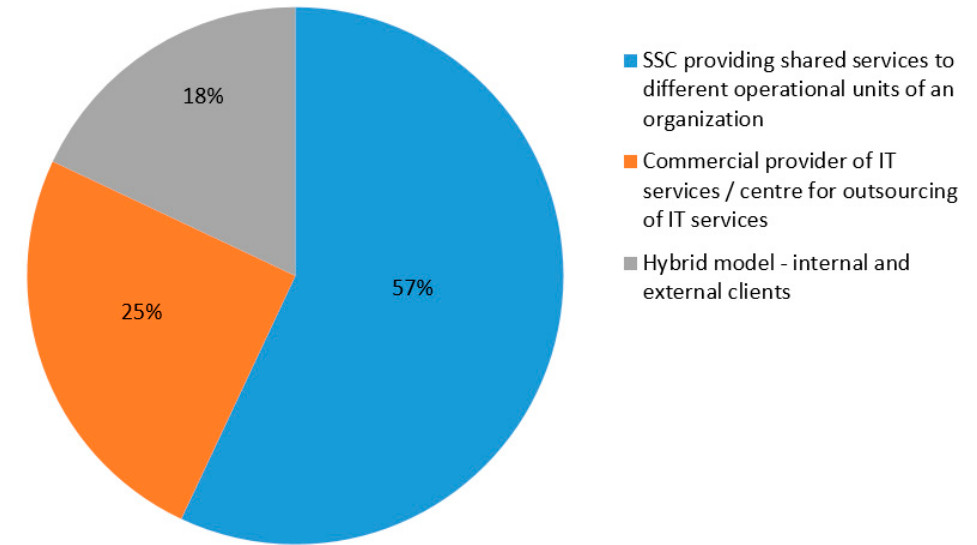
Figure 4. Types of shared services centres in 2005 in Poland. Source: Author’s original presentation based on ABSL report, www.paiz.gov.pl, access 8 September 2015.